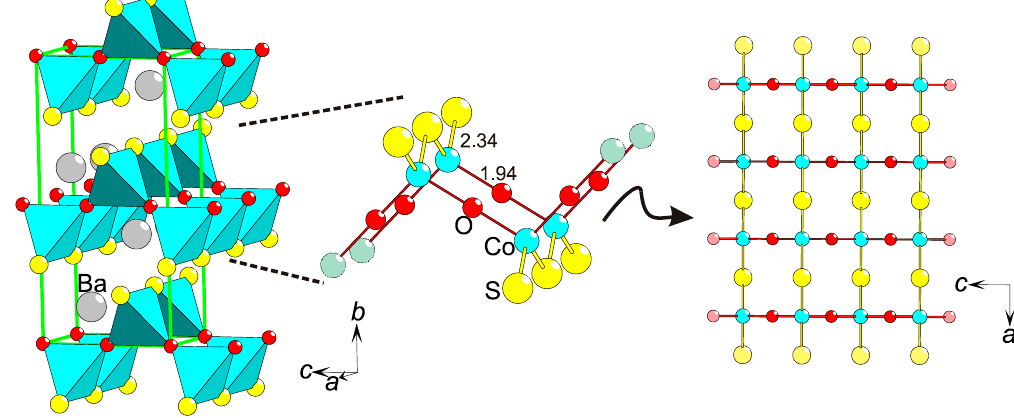
Figure 7. Magnetic anisotropy by chalcogen ordering in BaCoSO [46]. Displayed are: a part of the BaCoSO structure with unit cell in green ( left ), the local Co coordination ( center ), and the Co ´ S ´ O layer viewed along the b -axis. Interatomic distances are in Å.